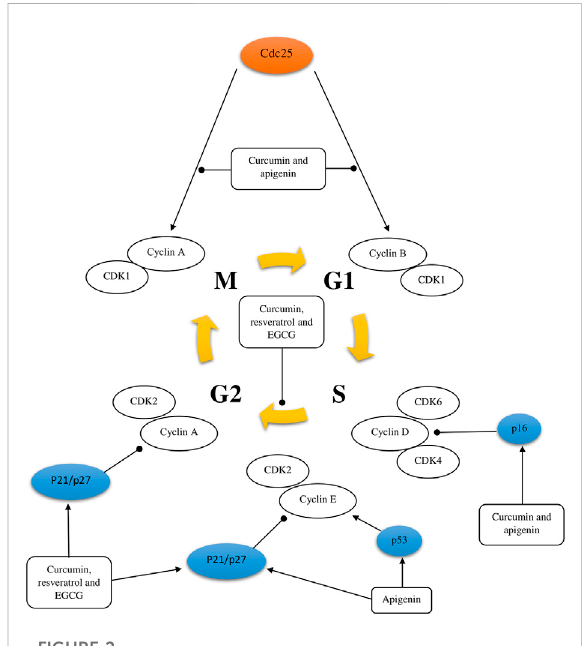
FIGURE 2 Schematic representation of cell cycle regulation. The activating and inhibitory effect of some polyphenols [curcumin, resveratrol, apigenin, and epigallocatechin-3-gallate (EGCG)] on the cell cycle of a tumor cell was